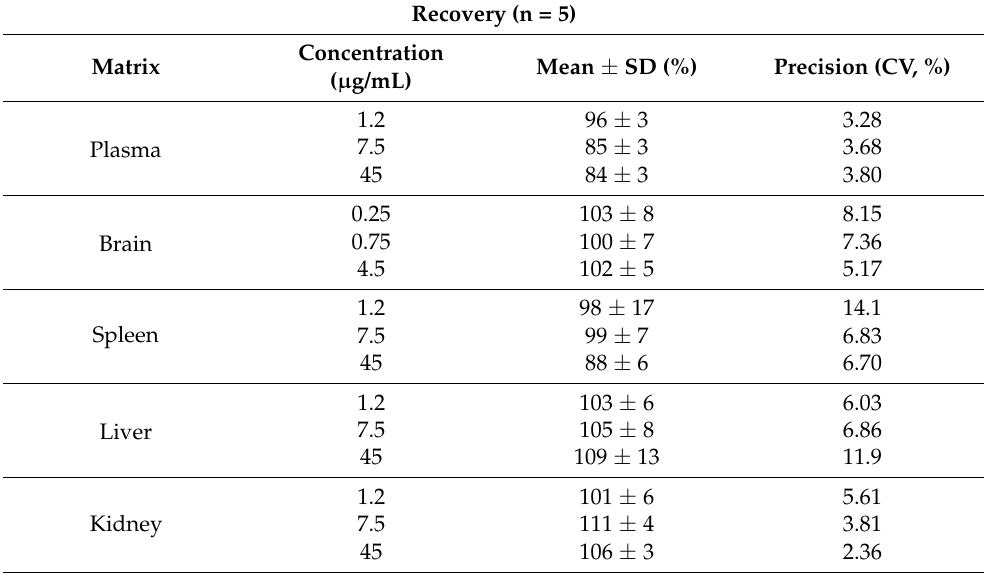
Table 5. Absolute recovery (values in mean percentage) of celecoxib from mouse matrices determined at low (QC1), middle (QC2), and high (QC3) concentration levels of the calibration range.